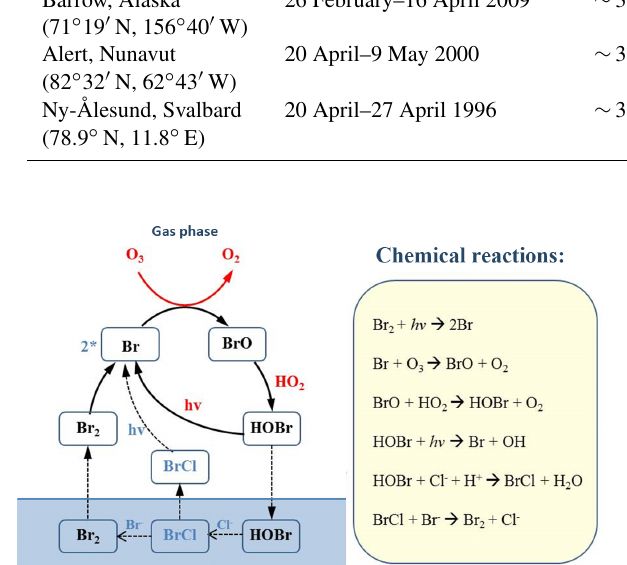
Figure 1. Chemical reactions of the BrO–ozone